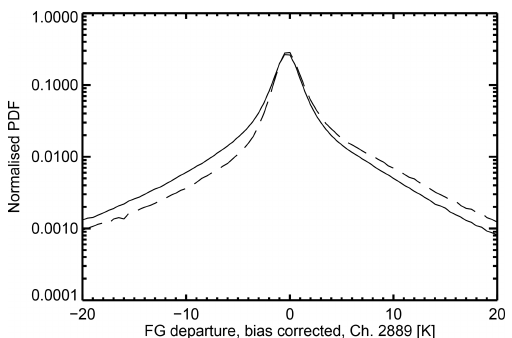
Figure 1. PDFs of bias-corrected background departures from 1 to 20 June 2017 in channel 2889 (the lowest peaking of the WV sound- ing weighting functions). The solid line is the sample prior to box thinning and the dashed line is after box thinning. Thinning removes 75% of remaining data, but the PDFs have been normalized in order to compare their